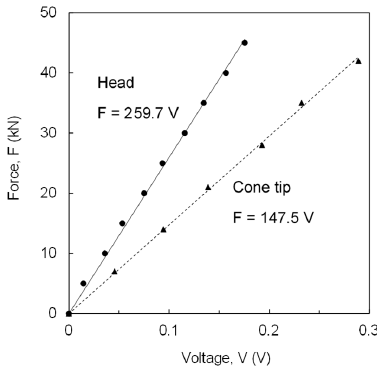
Figure 2. Mechanical force calibration of strain gauges. Input voltage is 5 V.